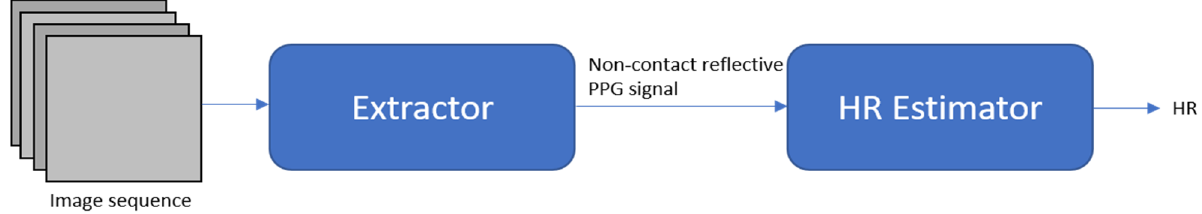
Figure 8. HR-CNN modules.